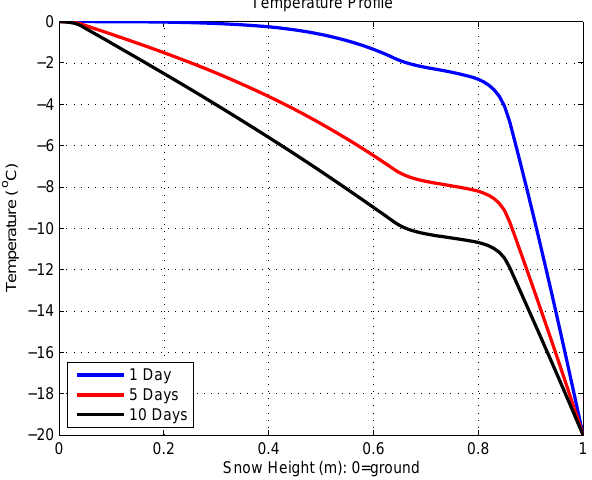
Figure 11. Snowpack temperature gradient profile at 1, 5, and 10 days, respectively.